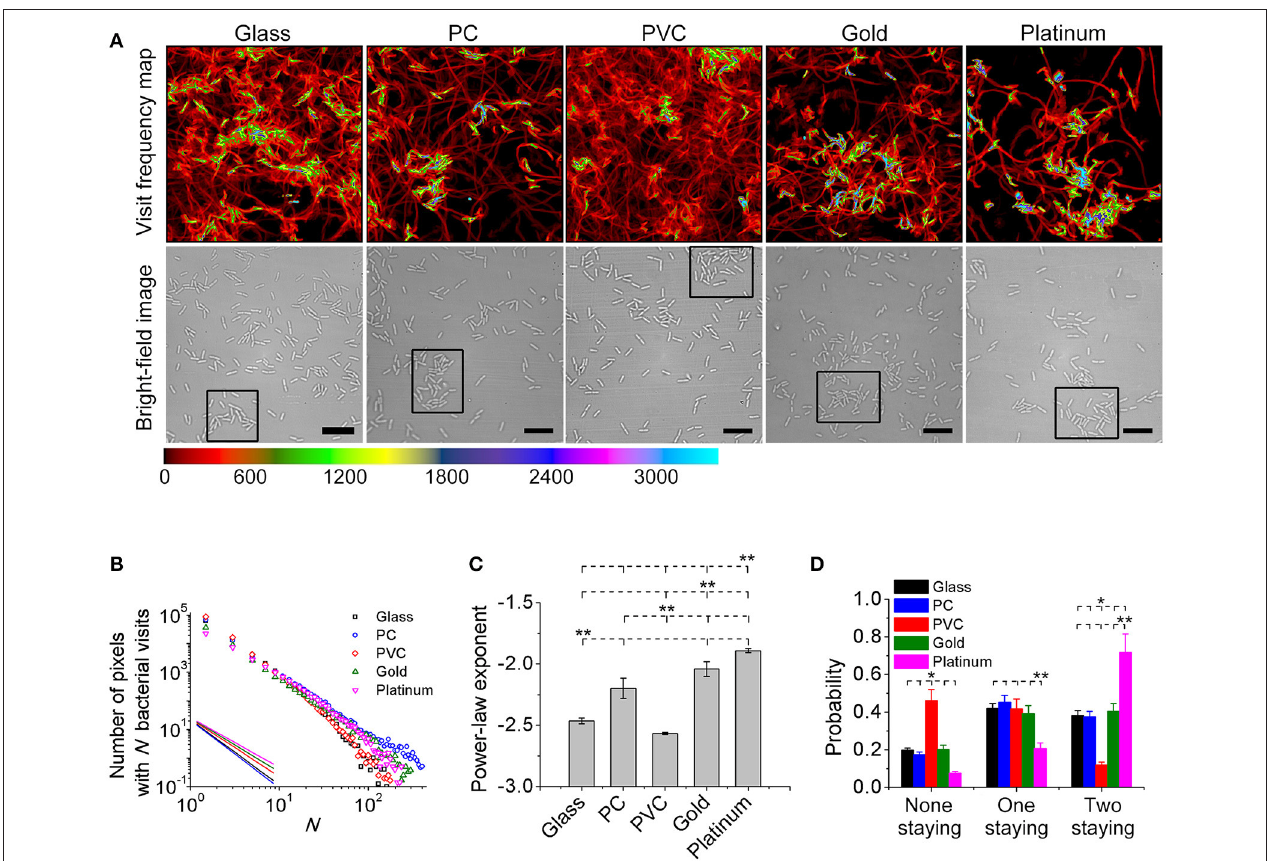
FIGURE 3 | Visit frequency distributions and post-division cell fates on different surfaces. (A) Visit frequency maps (top row) and bright-field images (bottom row) at total bacterial visits of 424,000 for glass, 393,800 for PC, 439,100 for PVC, 378,900 for gold, and 291,000 for platinum, respectively, when microcolonies are just starting to form (examples of first microcolonies in the field of view defined as clusters of 25 cells are outlined by black rectangles in the bright-field images). (B) Visit ∼ frequency distributions. Solid lines show power-law decay. (C) Power-law exponents obtained from B . Error bars are standard deviations of three repeats. (D) Probabilities of post-division cell fates. Error bars are estimated from 1/ √ N div , where N div is the total number of division events during the period of interest ( N div ≥ 100). Statistical significances are measured using unbalanced one-way ANOVA (Kruskal-Wallis test for distribution medians) and multiple comparison tests using Tukey’s honest significant difference criterion with a 0.05 significant value. * p < 0.1 and ** p < 0.05. The position of each asterisk indicates the reference material used in the statistical analysis. Scale bars are 10 µ